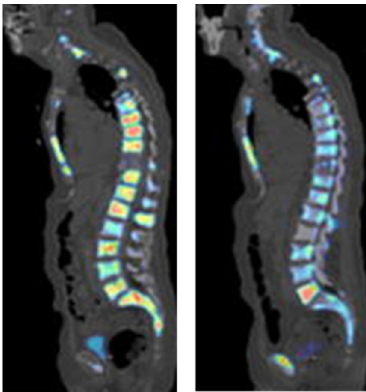
Figure 7. [ 18 F]Fluoride PET imaging of a PCa patient before (left image) and after (right image) treatment with dasatinib. This research was originally published in the Journal of Nuclear Medicine (JNM) [99].